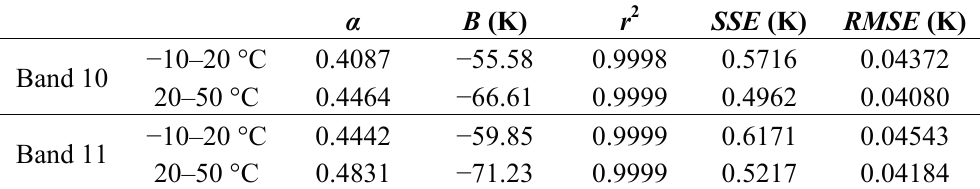
Table 1. Linear fitting coefficients for Parameter L